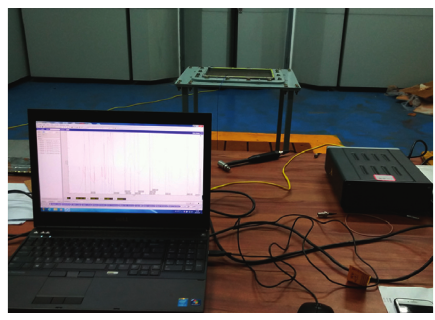
Figure 19: Experimental